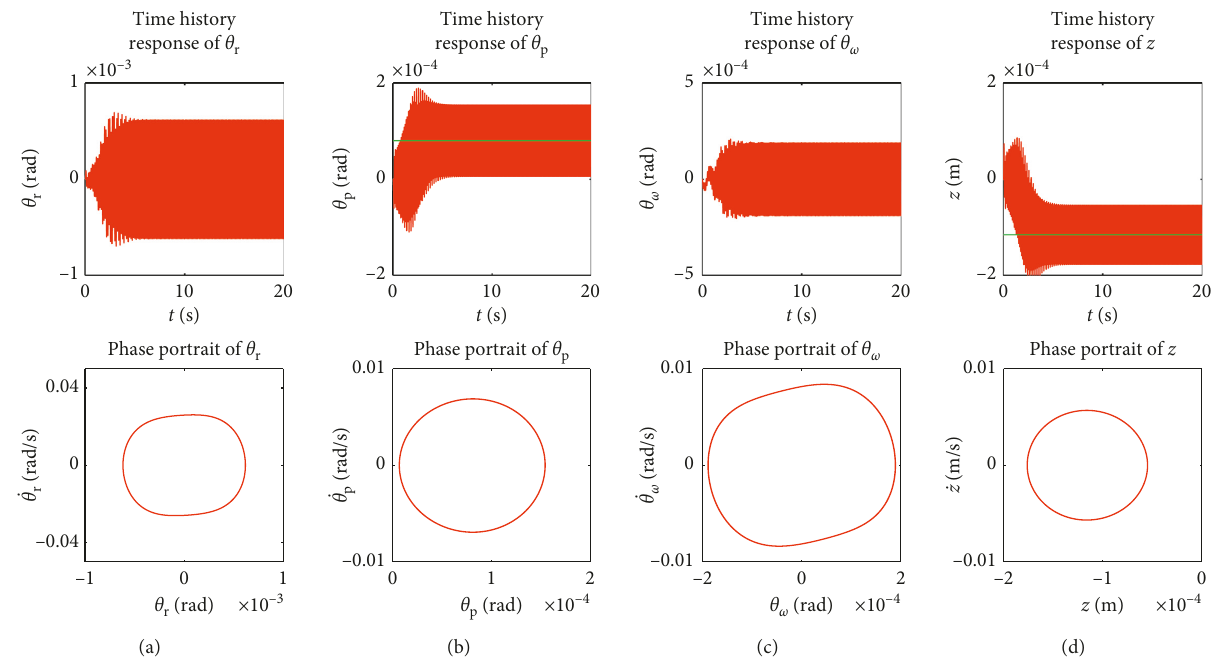
Figure 6: Dynamic responses of the motions of vehicle body. (a) Roll motion. (b) Pitch motion. (c) Yaw motion. (d) Vertical motion.